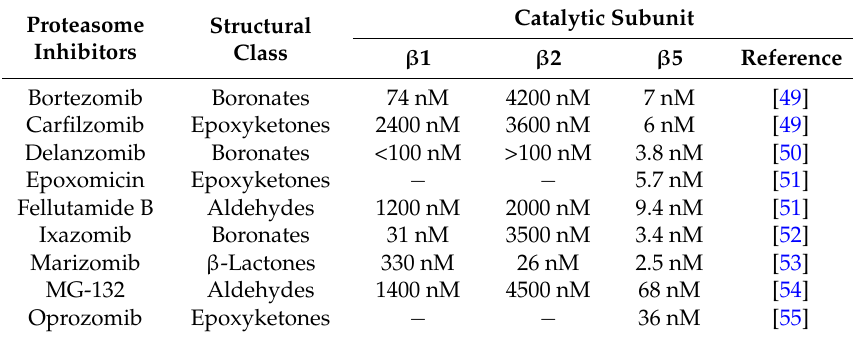
Table 1. Representative examples of proteasome inhibitors and IC 50 values on the targeted active site(s).